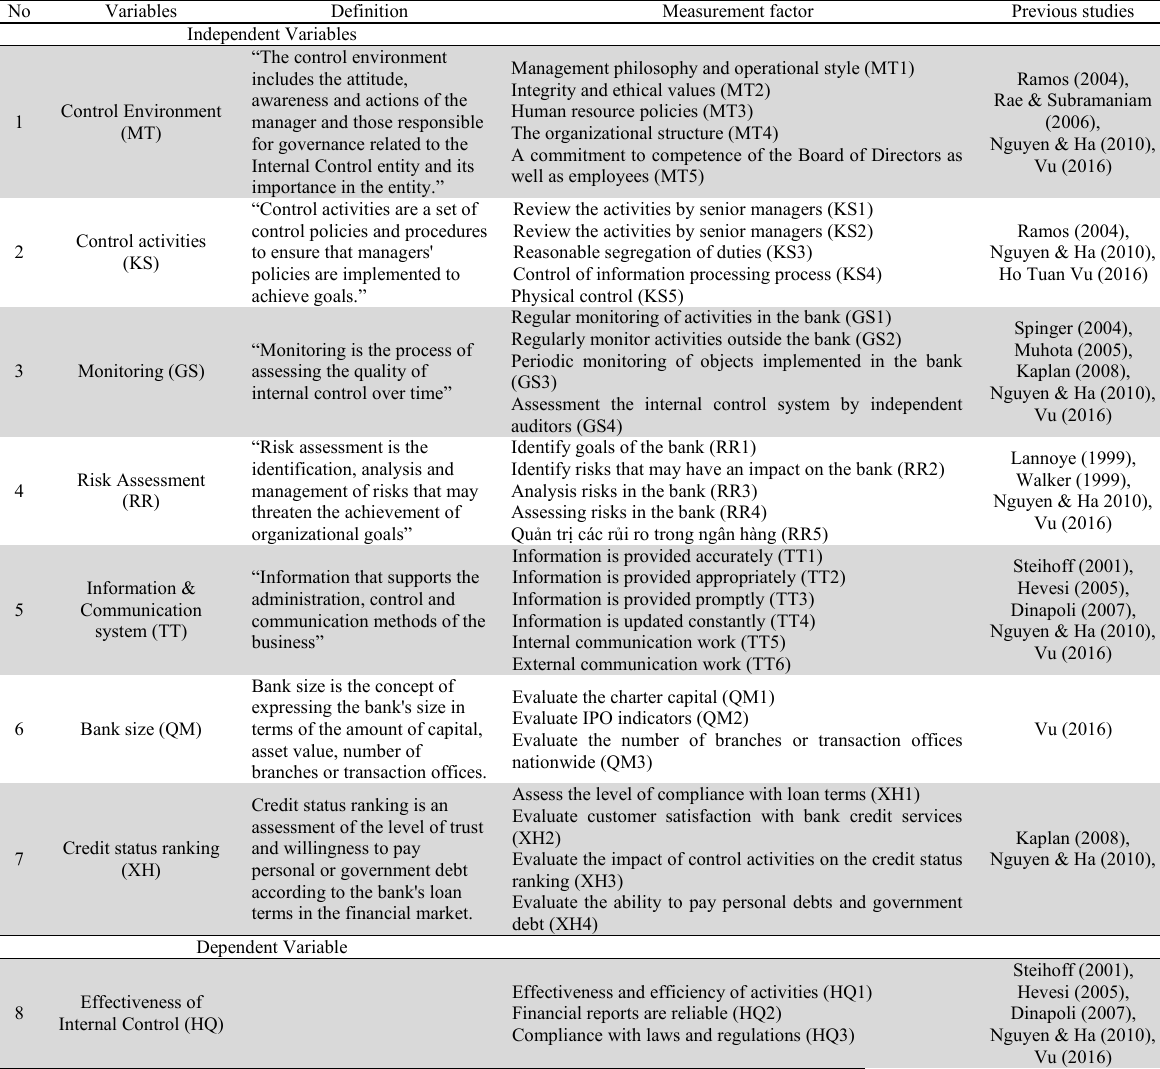
Summary of research factors at joint stock commercial